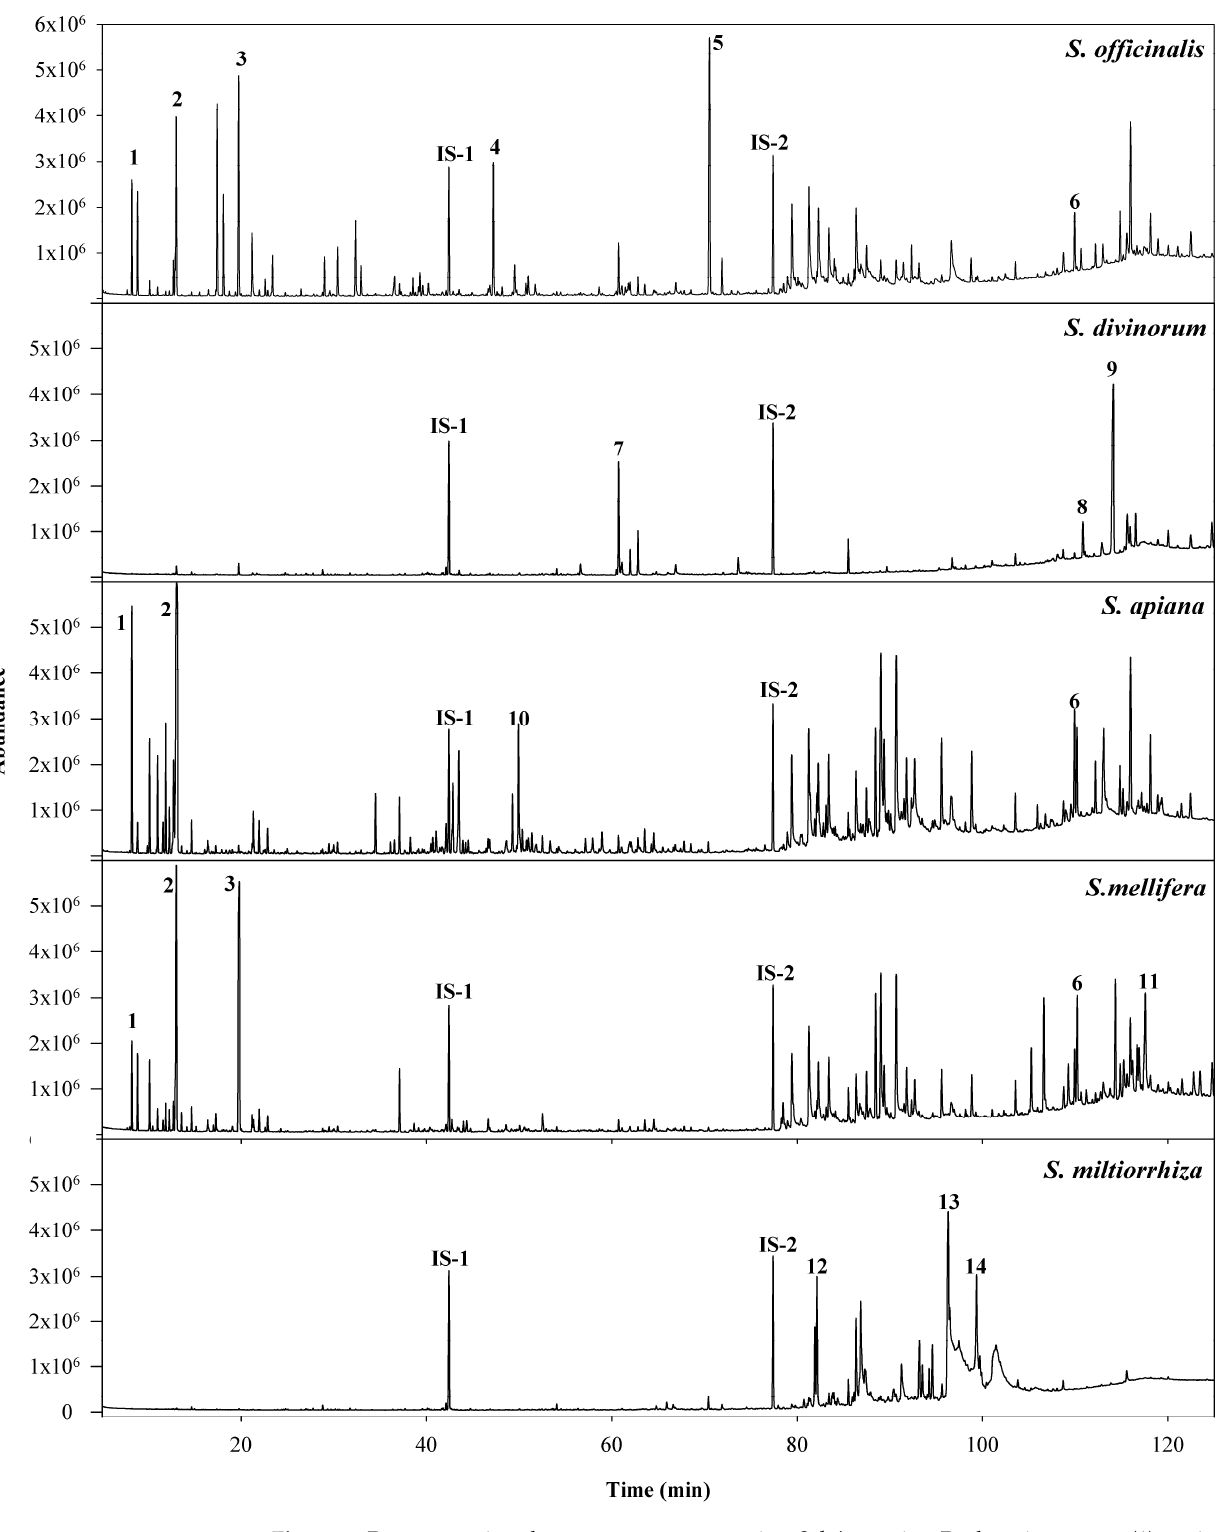
Figure 1. Representative chromatograms comparing Salvia species. Peak assignments: (1) α -pinene; (2) 1,8 cineole; (3) camphor; (4) viridiflorol; (5) verticiol; (6) salvigenin; (7) 8-hexadecyne; (8) salvinorin B; (9) salvinorin A; (10) γ -gurjunene; (11) lupeol; (12) ferruginol; (13) tanshinone II; (14) cryptotanshinone; (IS-1) tridecane; (IS-2) docosane.